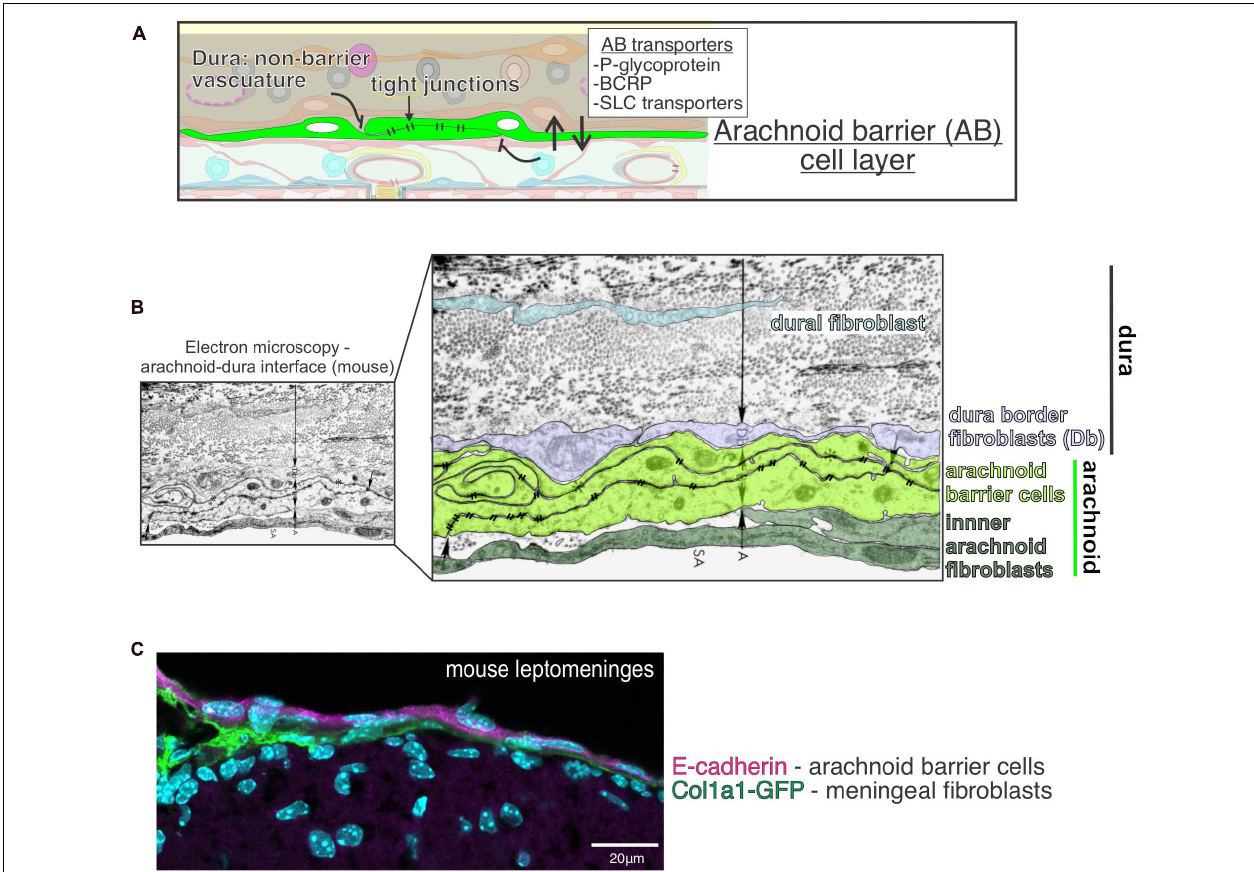
FIGURE 2 | Function and structure of the arachnoid barrier layer in the meninges. (A) Graphical depiction of proposed functions of the arachnoid barrier layer of the meninges including (1) as a physical barrier preventing free movement of molecules and cells into the subarachnoid space by virtue of its tight junctions, (2) enriched expression of efflux (P-glycoprotein, BCRP) and solute transporters (SLC) by arachnoid barrier cells support regulated movement of molecules across this barrier layer. (B) Electron microscopy image of the mouse arachnoid-dura interface, reproduced with permission from Nabeshima et al. (1975). Pseudo-coloring of the cell bodies highlights close interface between cells of the arachnoid (A) (inner arachnoid fibroblasts and arachnoid barrier cells connected by electron-dense tight junctions) and cells of the dura, [dura border cells (Db) and dural fibroblasts within collagen fibril dense dura layer]. (C) Immunofluorescence image of mouse leptomeninges from a postnatal day 14 Col1a1-GFP mouse brain with E-cadherin (magenta) and DAPI (cyan). E-cadherin is expressed by arachnoid barrier cells (representing the outer part of the arachnoid layer) but not by inner Col1a1-GFP+ fibroblasts, representing pial and inner arachnoid fibroblasts. Image reproduced with permission from DeSisto et al.